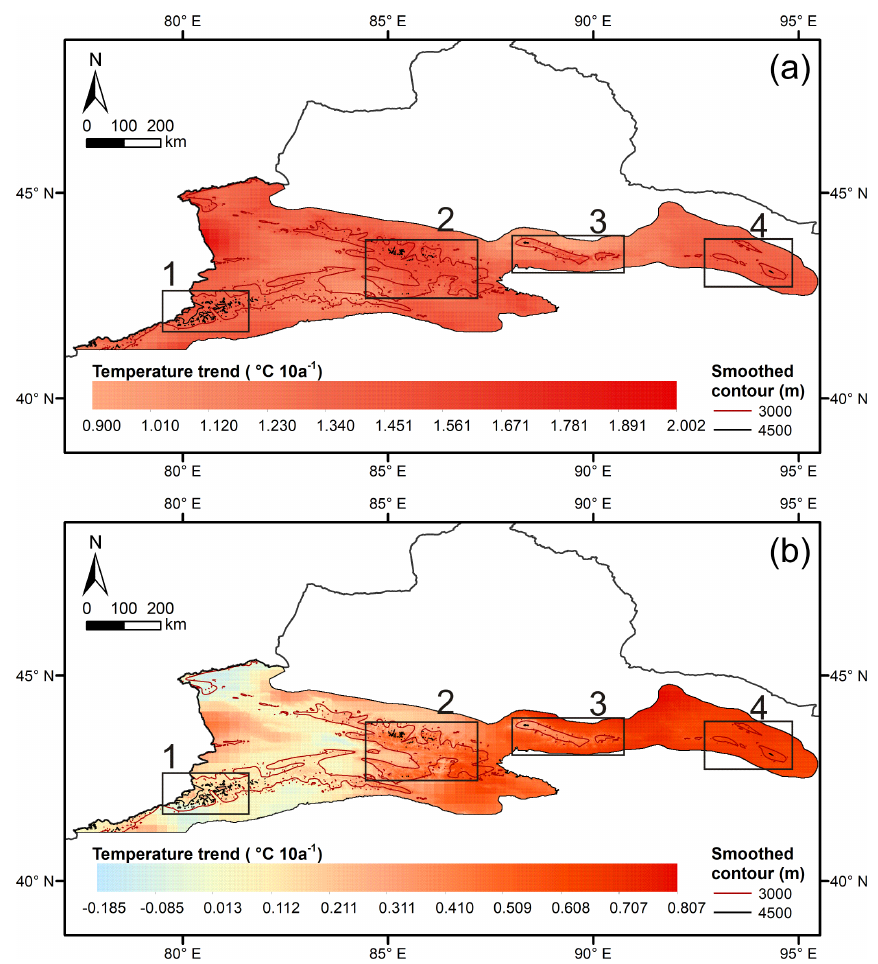
Figure 7. Monthly maximum temperature trends in (a) March and (b) September for the entire CTM from 1979 to 2016.